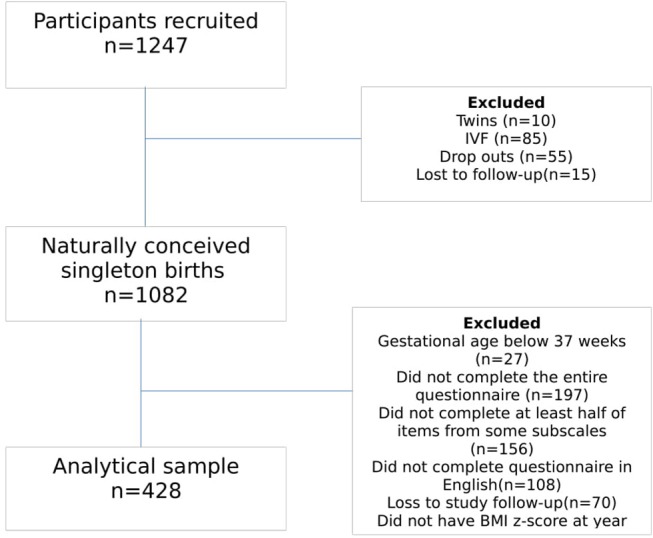
Flow chart of study participants included at timepoints 4, 5, and 6 years old.